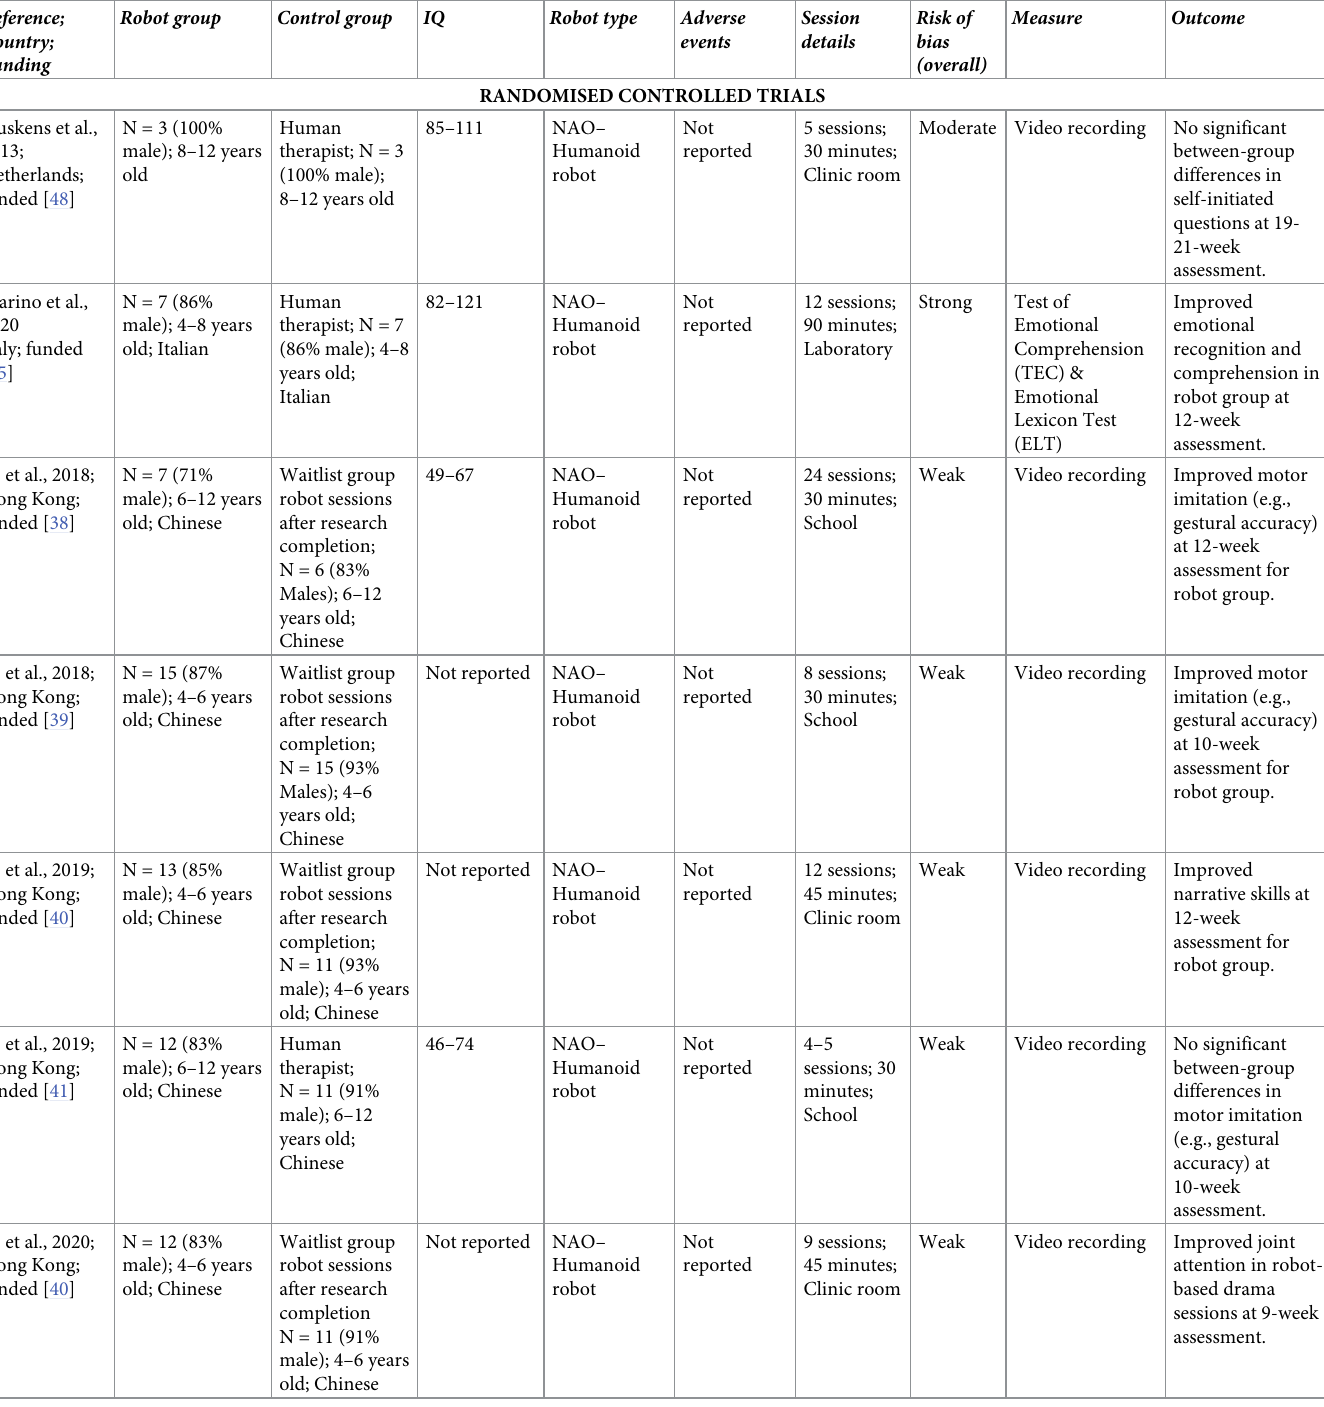
Table 1. Summary of study characteristics sorted by study design and mostly used robot. Reference;